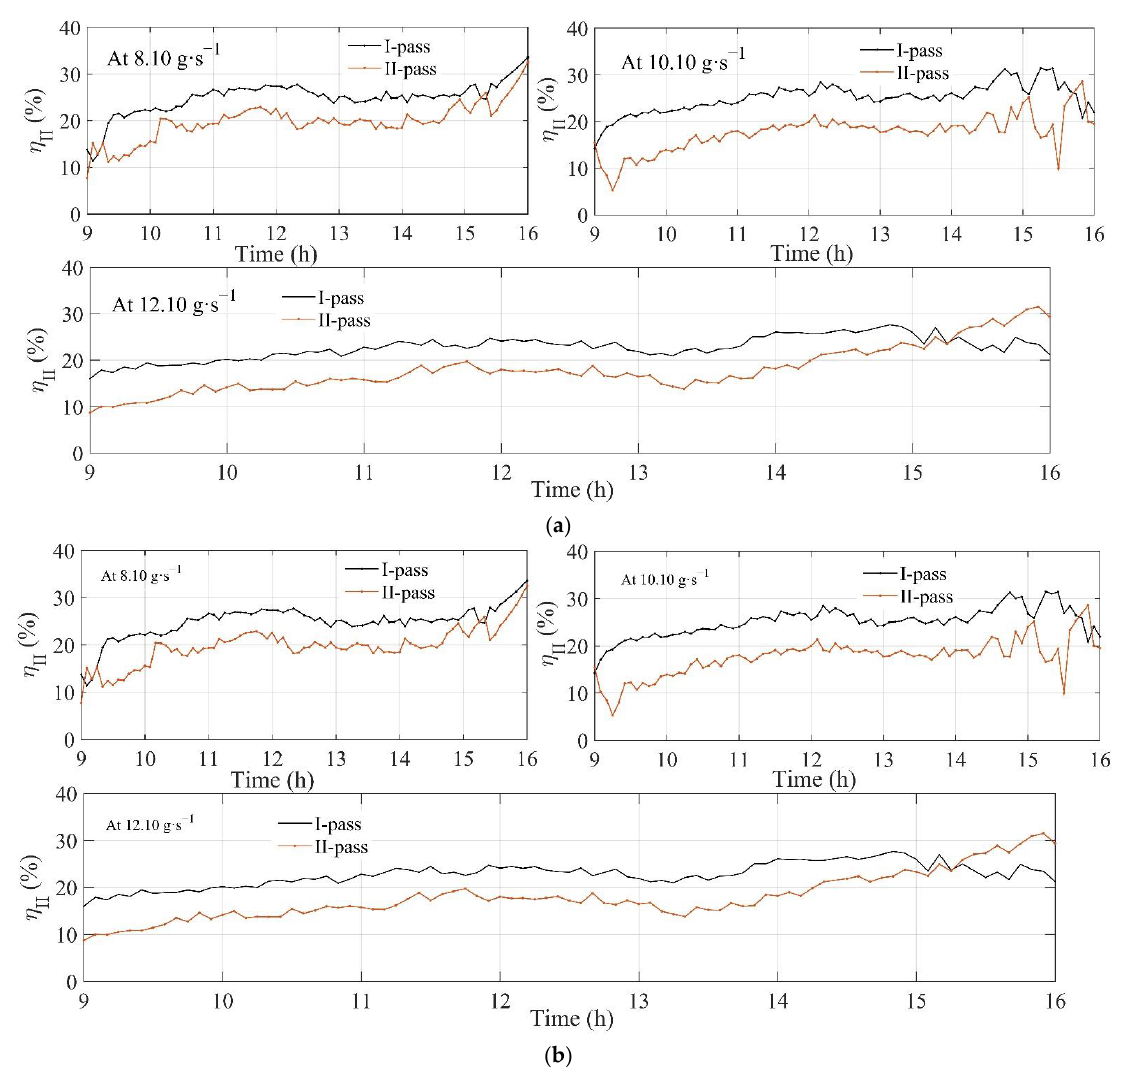
Figure 7. The change in the second law efficiency of the two-pass solar air collector with time (( a ) Collector-I, ( b )